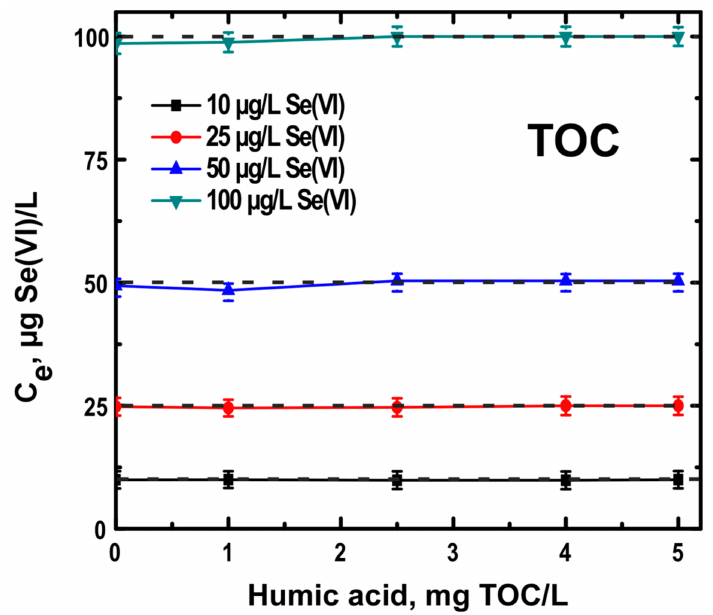
Figure 8. Influence of commonly found in natural waters NOM concentrations (as determined by TOC) on Se(VI) adsorption by Bayoxide. Experimental conditions: Bayoxide concentration 0.5 g/L, 30 min.